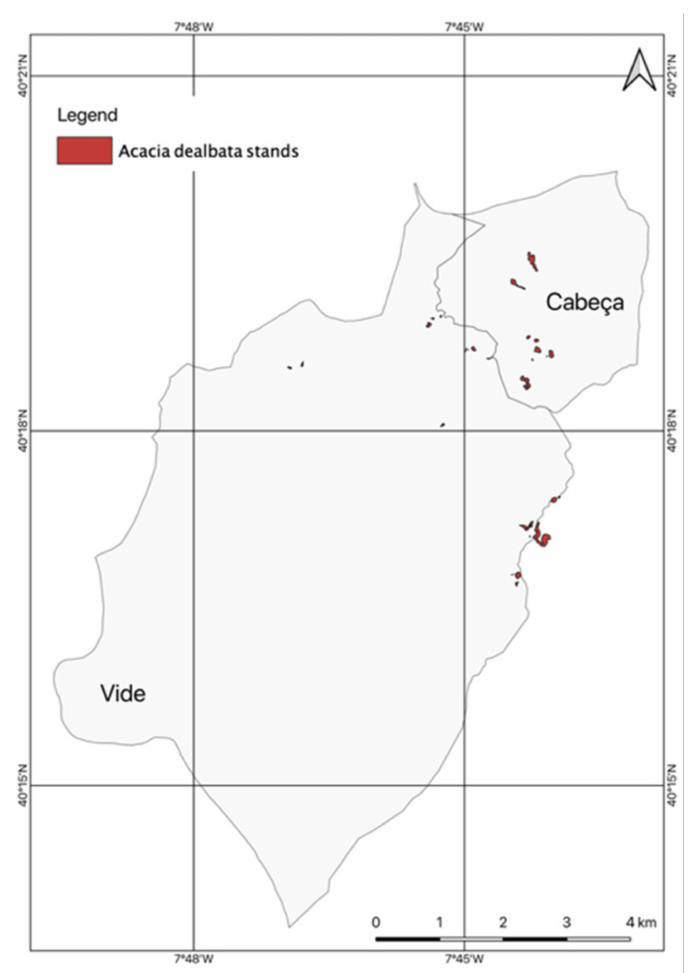
Figure 7. The areas occupied by A. dealbata stands in the Uni ã o de Freguesias de Vide e